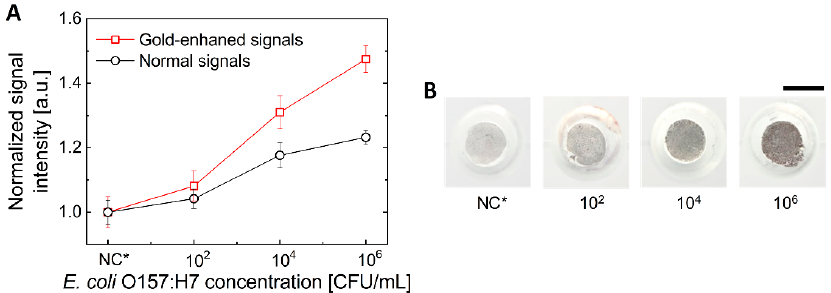
Figure 6. The results of colorimetric detection of E. coli O157:H7 on a finger-powered microfluidic device with signal enhancement. ( A ) The colorimetric signal was enhanced by incubation with a gold enhancer solution. NC* indicates negative control. ( B ) Images of an enhanced colorimetric signal on the membrane filter. Scale bar = 3